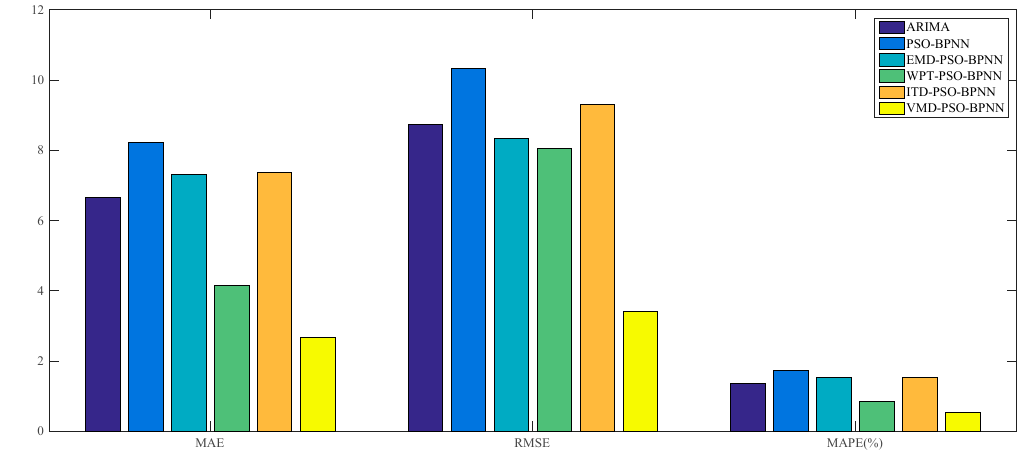
Figure 12. Error graphics of different models of wheat. Table 3. Forecasting performance evaluation of